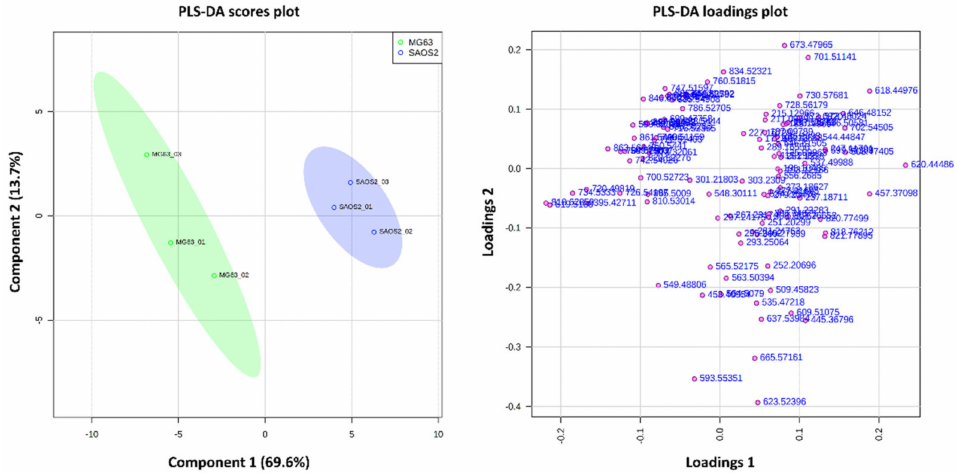
Figure 3. PLS-DA scores and loadings plot show variance between MG63 aggregoid model and the SAOS-2 aggregoid model. Component 1 (69.6%) and component 2 (13.7%) showed the best separation between samples. The discriminatory m / z values of interest were distributed separately from the cluster of peaks. Samples were grouped with 95% confidence, MG63 (green) and SAOS-2 (blue).